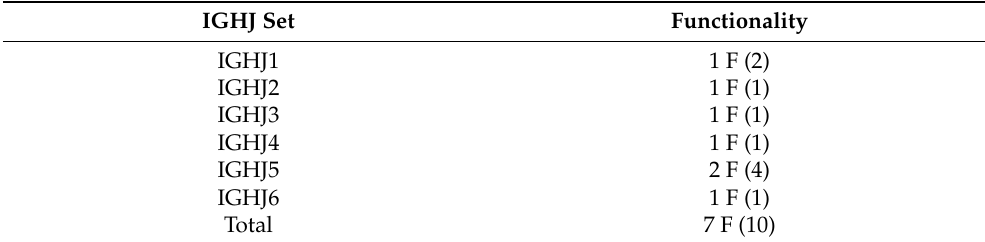
Table 5. For each IGHJ set, number of IGHJ genes per functionality and, between parentheses, number of alleles. IGHJ Set Functionality IGHJ1